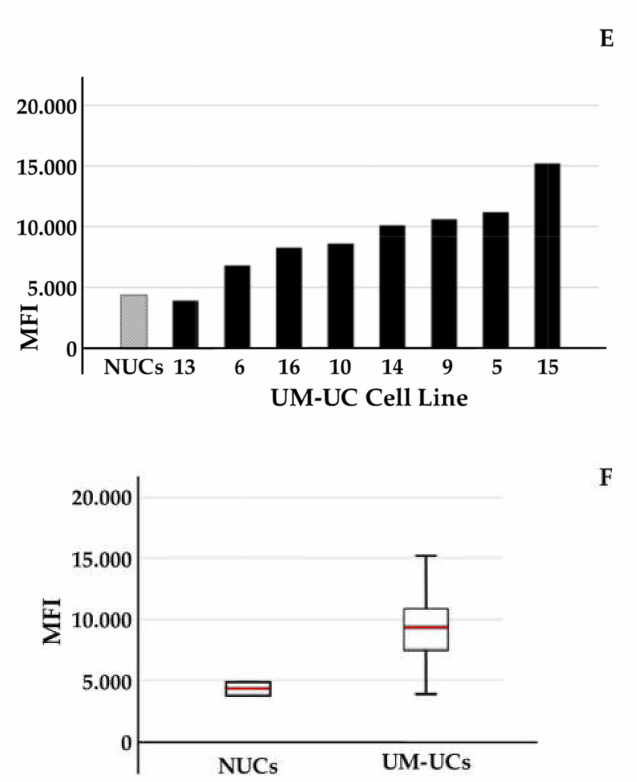
Figure 3. Expression of CD276 in urothelial cells. Expression of CD276 was investigated on the transcript ( A ), total protein ( B , C ), and cell surface ( D – F ) levels of NUCs and UM-UCs as indicated. ( A ) Steady-state mRNA expression was normalized to transcripts encoding 2 housekeeping controls. Red lines indicate the mean expression ± standard deviation from 3 individual analyses of cells as indicated. ( B ) Protein expression of CD276 was quantified by Western blot (left panel) and compared to expression of ß-actin (right panel). ( C ) Protein expression of CD276 was quantified by a blot scanner and normalized to the expression of ß-actin. Red lines indicate the normalized mean expression ± standard deviations. ( D ) The mean fluorescence intensity (MFI) of anti-CD276 staining of cells was investigated by flow cytometry of cells as indicated. The figure presents a representative experiment. The x-axis shows the log of the signal intensities, the y-axis the normalized cell numbers analyzed. Solid histograms denote CD276 staining, gray histograms the controls. ( E ) Comparison of the mean fluorescence intensities of CD276 staining of urothelial cells as indicated. ( F ) Mean fluorescence intensities of NUCs in comparison to all UM-UC cells investigated. Red lines indicate the mean expression